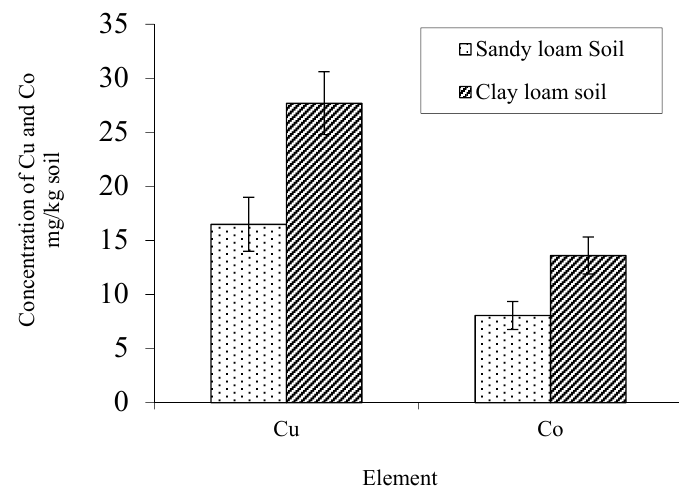
Figure 1. Means of concentration of Cu and Co in the soil after the crops were harvested. The error bars shown are the standard error of means.